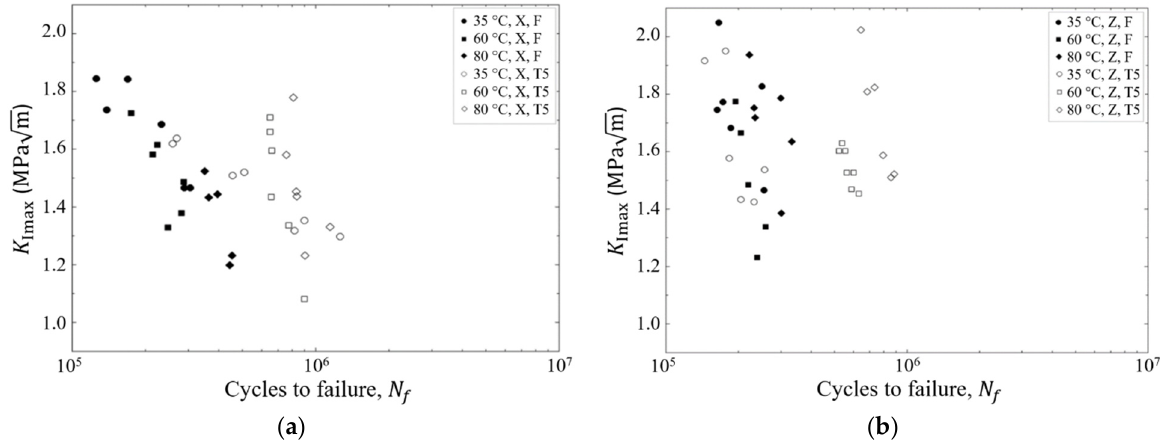
Figure 17. Fatigue results for X ( a ) and Z ( b ) specimens produced on a platform preheated at 35 °C, 60 °C and 80 °C presented in terms of maximum stress intensity factor ( K Imax ) characterizing defects at crack origins and number of cycles to failure ( N f ) for a stress amplitude of 135